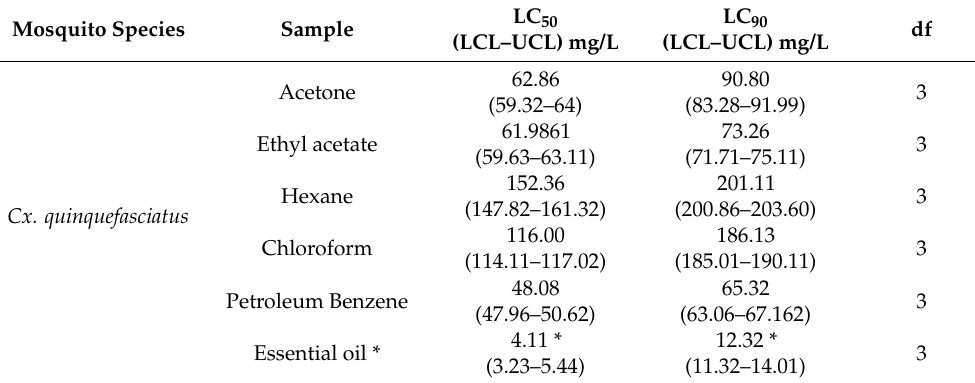
Table 3. Larvicidal activities of A. nilotica seed extracts and essential oil against the fourth instar larvae of Cx. quinquefasciatus .